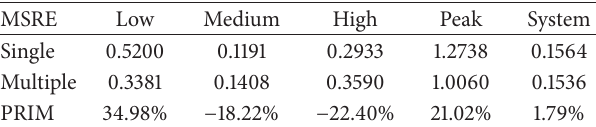
Table4:PerformanceevaluationresultsofMSREbetweenthesingle and the two-stage multiple SVM in June 2009.